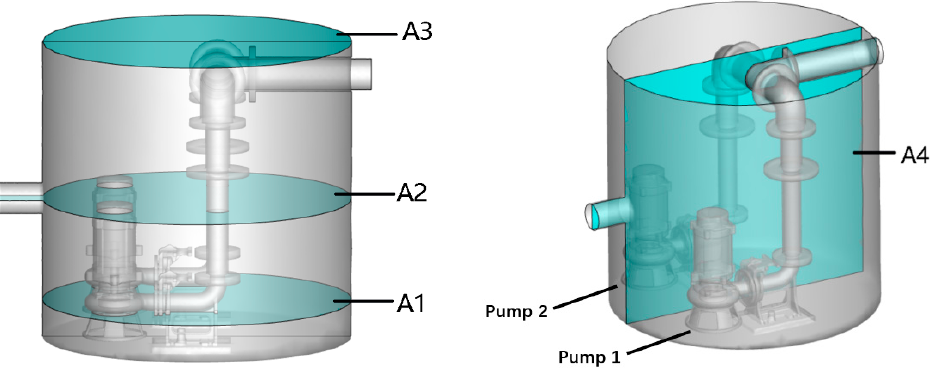
Figure 6. Schematic diagram of centrifugal prefabricated pumping station cross-section. The velocity and streamline distributions of A1–A4 sections of centrifugal prefabri- cated pumping stations at 0.33 Q d , 0.67 Q d , 1.00 Q d , 1.33 Q d , 1.67 Q d , and 2.00 Q d flow condi- tions are shown below.